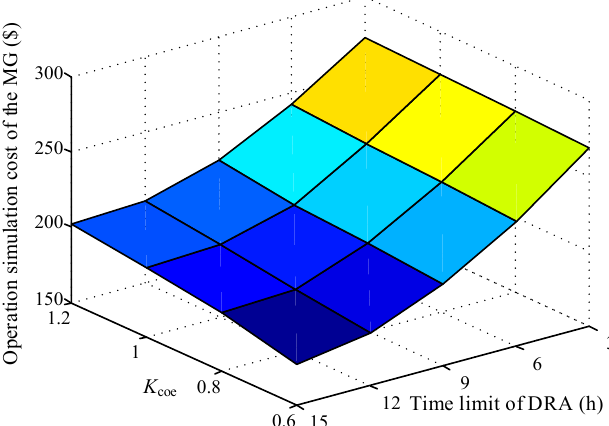
Figure 11. Operation simulation cost of the MG under different combinations of the unit capacity cost of scheduled interruptible power and the time limit of DRA.